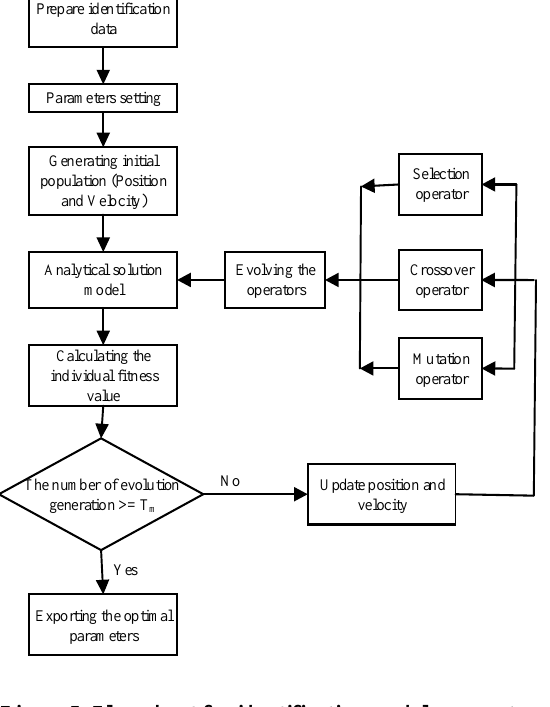
Figure 5. Flow chart for identification model parameters based on PSO-GA.